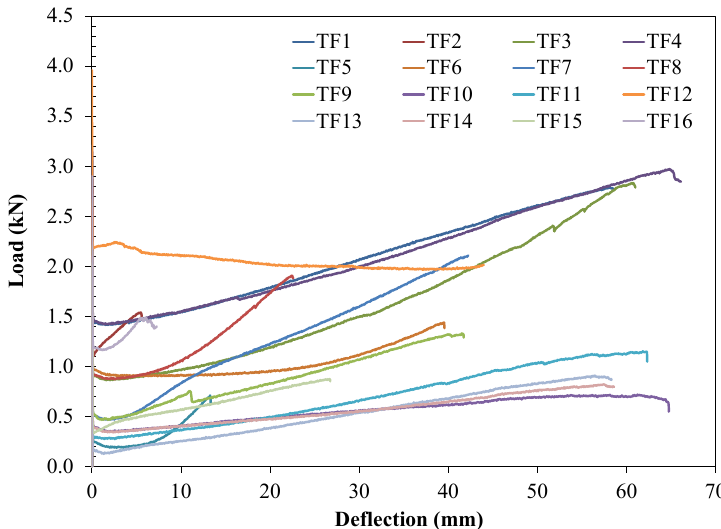
Figure 12. Load ‐ deflection behavior of textile fabrics in warp direction.